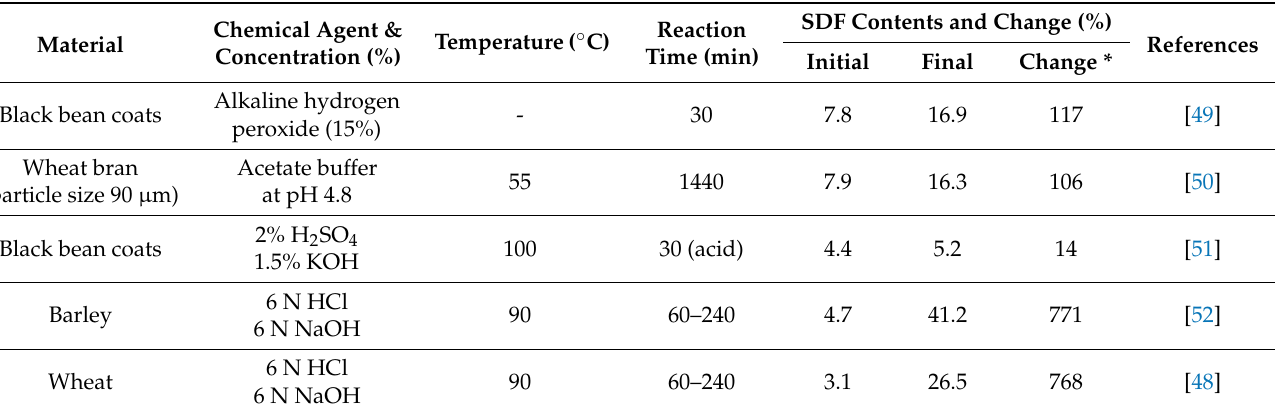
Table 5. Some examples of chemical treatment methods applied to influence DF composition. (SDF content is related to total initial